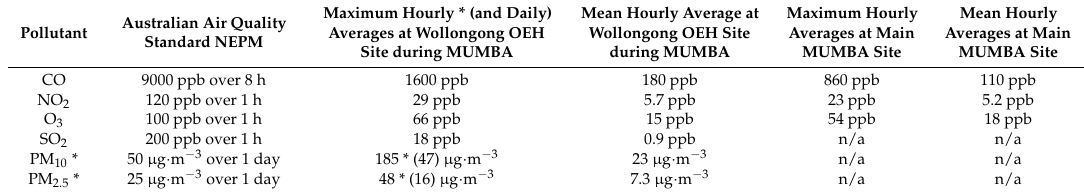
Table 2. Maximum and mean hourly average concentrations of key pollutants measured at the Wollongong OEH station throughout the MUMBA campaign and the relevant Australian Air Quality Standards. * Where standards apply over an averaging period of one day, values for daily averages are also given in